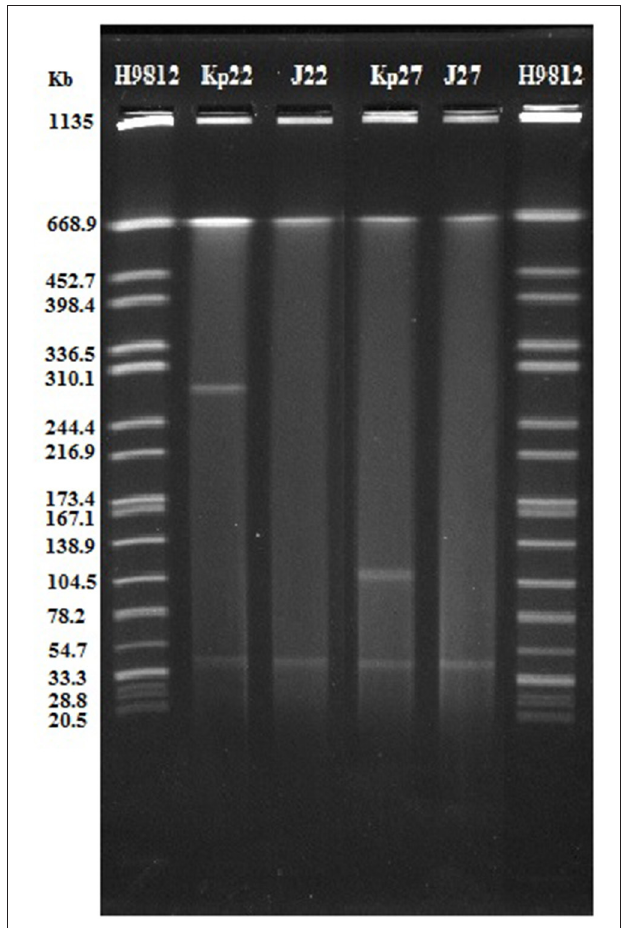
FIGURE 2 | S1- PFGE results for Kp22 and Kp27 and their transconjugants.